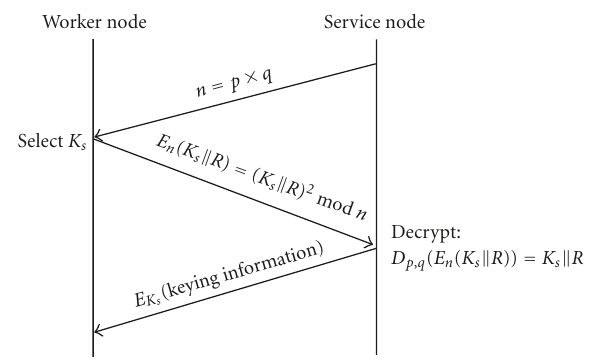
Figure 2: Service sensor association. A worker node associates itself to a service sensor to obtain the keying information through a secure channel established based on Rabin’s public